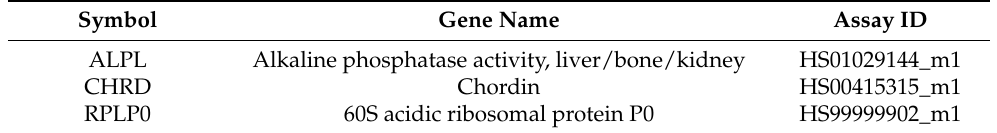
Table 1. TaqMan™ Gene Expression